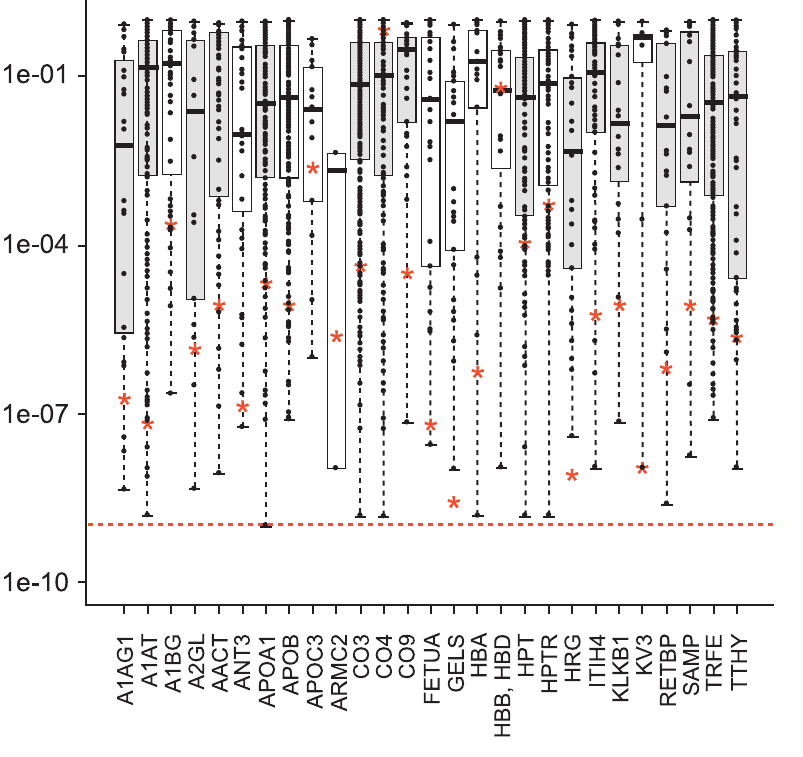
Figure 7. Significance levels from the proteins, constituent peptides, and acute phase pathway intensities. p-values for the proteins are shown by red stars, p-values for individual peptides are shown by points, and the distribution of these for each protein is shown by a boxplot. In each boxplot, the upper and lower sides of the box represent the higher and lower quartile values (Q3 and Q1), respectively. The black bar in each box represents the median value. The p-value for the acute phase pathway is represented by the dashed line; boxplots for proteins in the acute phase response pathway are shaded. A1AG1 = alpha-1-acid glycoprotein 1; A1AT = alpha-1-antitrypsin; A1BG = alpha-1B-glycoprotein; A2GL = leucine- rich alpha-2-glycoprotein; AACT = alpha-1-antichymotrypsin; ANT3 = antithrombin-III; APOA1 = apolipoprotein A-I; APOB = apolipoprotein B-100; APOC3 = apolipoprotein C-III; ARMC2 = armadillo repeat-containing protein 2; CO3 = complement C3; CO4 = complement C4-A; complement C4- B; CO9 = complement component C9; FETUA = alpha-2-HS-glycoprotein; GELS = gelsolin; HBA = hemoglobin alpha; HBB, HBD = hemoglobin beta/delta; HPT = haptoglobin; HPTR = haptoglobin-related protein; HRG = histidine-rich glycoprotein; ITIH4 = inter-alpha-trypsin inhibitor heavy chain H4; KLKB1 = plasma kallikrein; KV3 = Ig kappa chain V-III region Ti; RETBP = retinol binding protein 4; SAMP = serum amyloid P-component; TRFE = serotransferrin; TTHY = transthyretin.